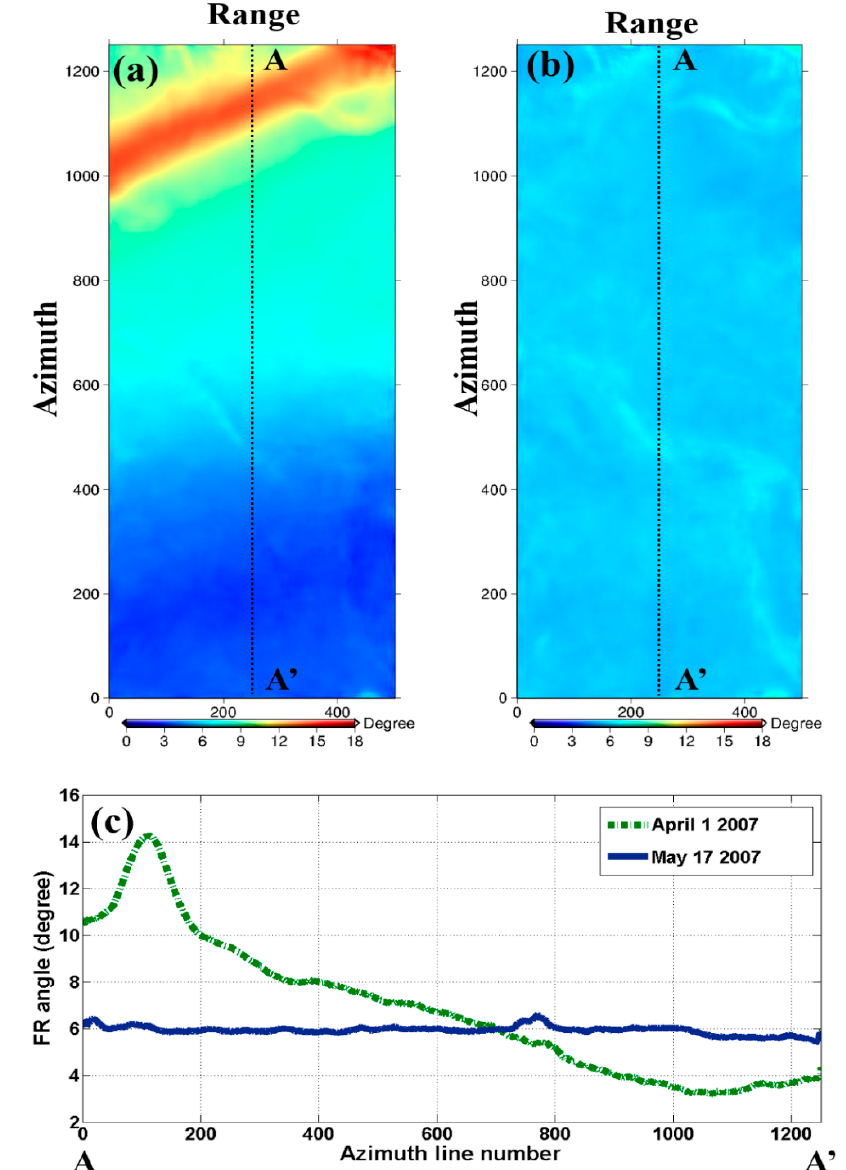
Figure 3. Faraday rotation (FR) angles. ( a , b ) FR angle maps from 1 April and 17 May 2007, respectively, ( c ) the FR angle values in the profiles A-A’ of ( a ) and ( b ).